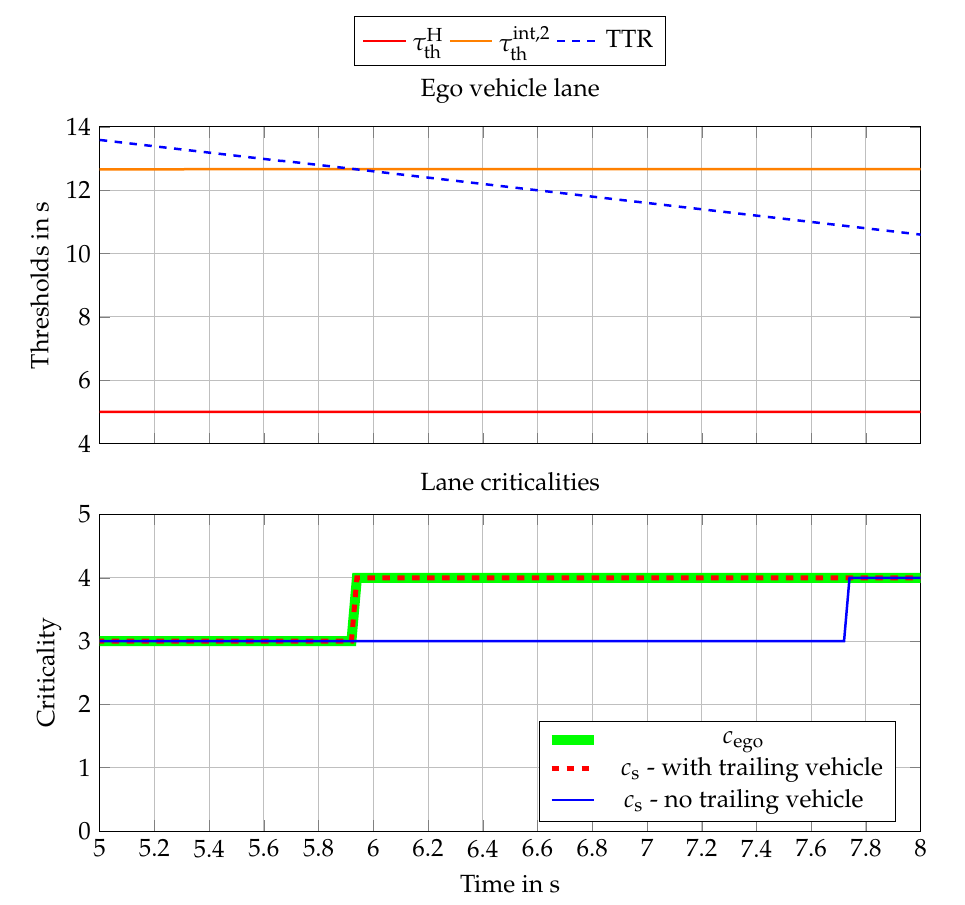
Figure 8. Criticality assessment results for the time frame between 5s and